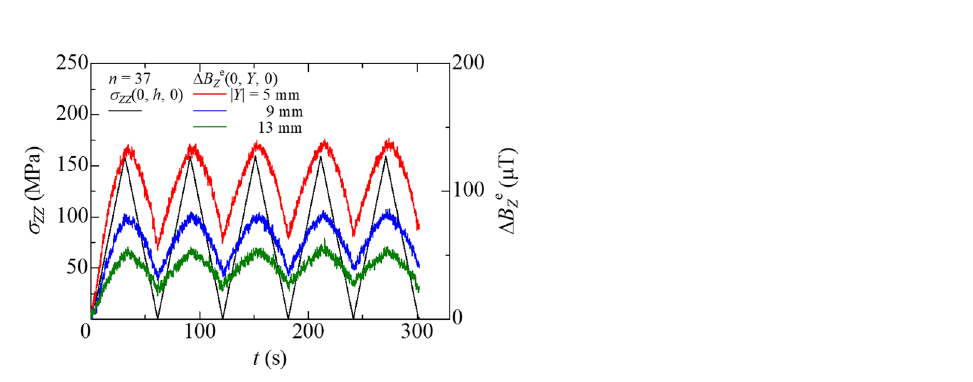
Figure 7. ( a ) Experimental setup of four-point bending test, ( b ) sketch of magnetic flux density distribution caused by external bending load, ( c ) the Hall probes’ position for measurement of magnetic flux density distribution, and ( d ) four-point bending test program.